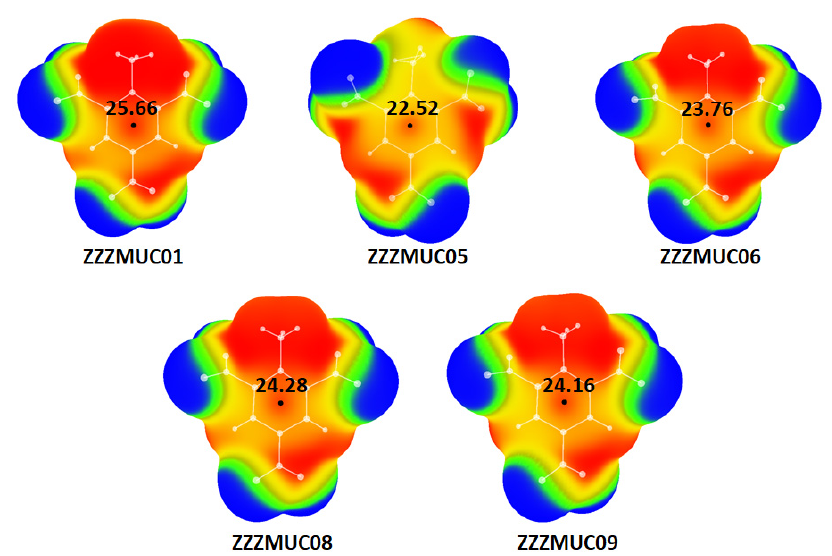
Figure 4. Electrostatic potential maps calculated for the geometries of TNT molecule found in crystal structures achieved in CSD. Color ranges (in kcal/mol): red, greater than 20.92, yellow, from 0.00 to 20.92, green, from − 6.99 to 0.00, and blue, more negative than 6.99. Table 3. Total energies, V max deviations and V max values in critical points above the centers of nitroaromatic rings calculated for selected crystal structures containing TNT molecule.